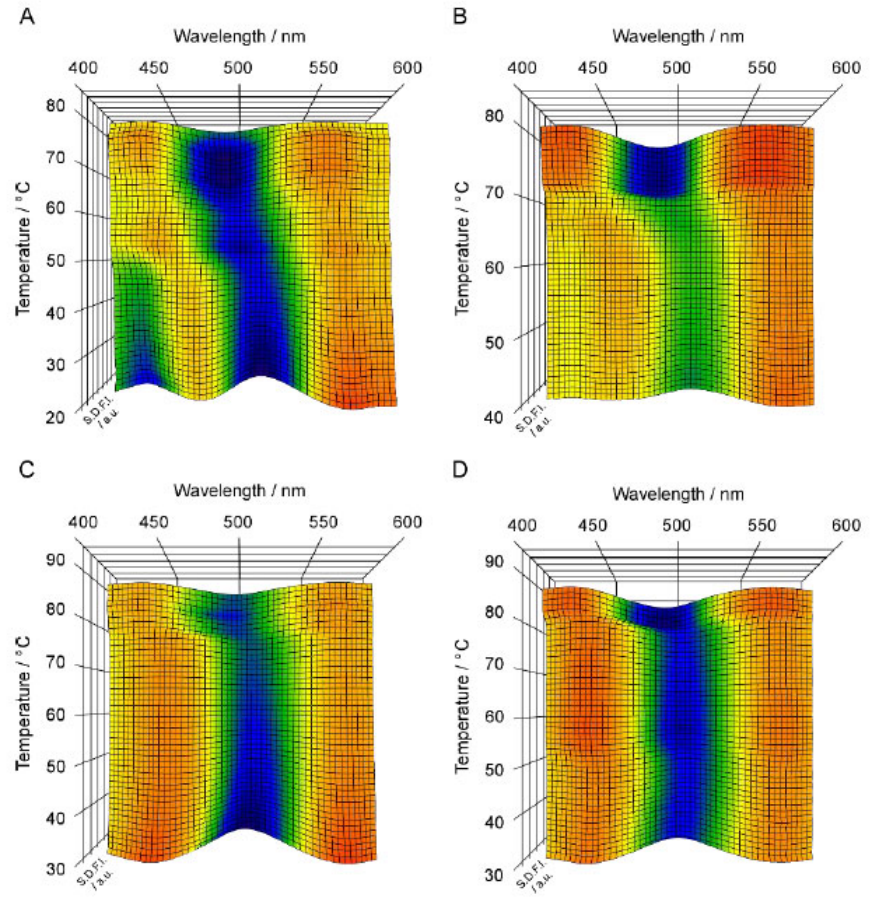
Figure 4. Spectral 3D imaging plots for C n PC bilayer membranes ( n = 19–22): ( A ) C19PC, ( B ) C20PC, ( C ) C21PC, ( D ) C22PC. The heating process along which the Prodan fluorescence spectroscopic observation was carried out to construct each 3D imaging plot is given as an arrow shown in Figure